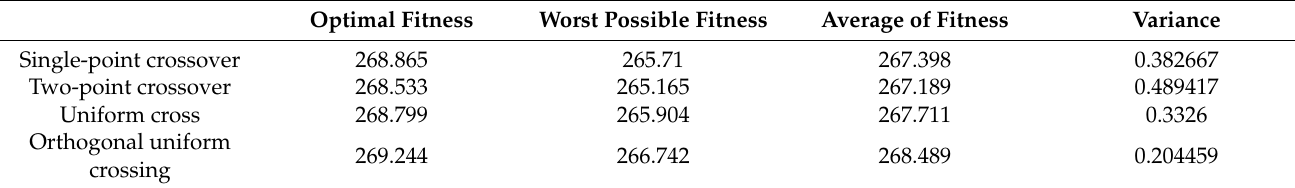
Table 3. Experimental results of crossover operator performance